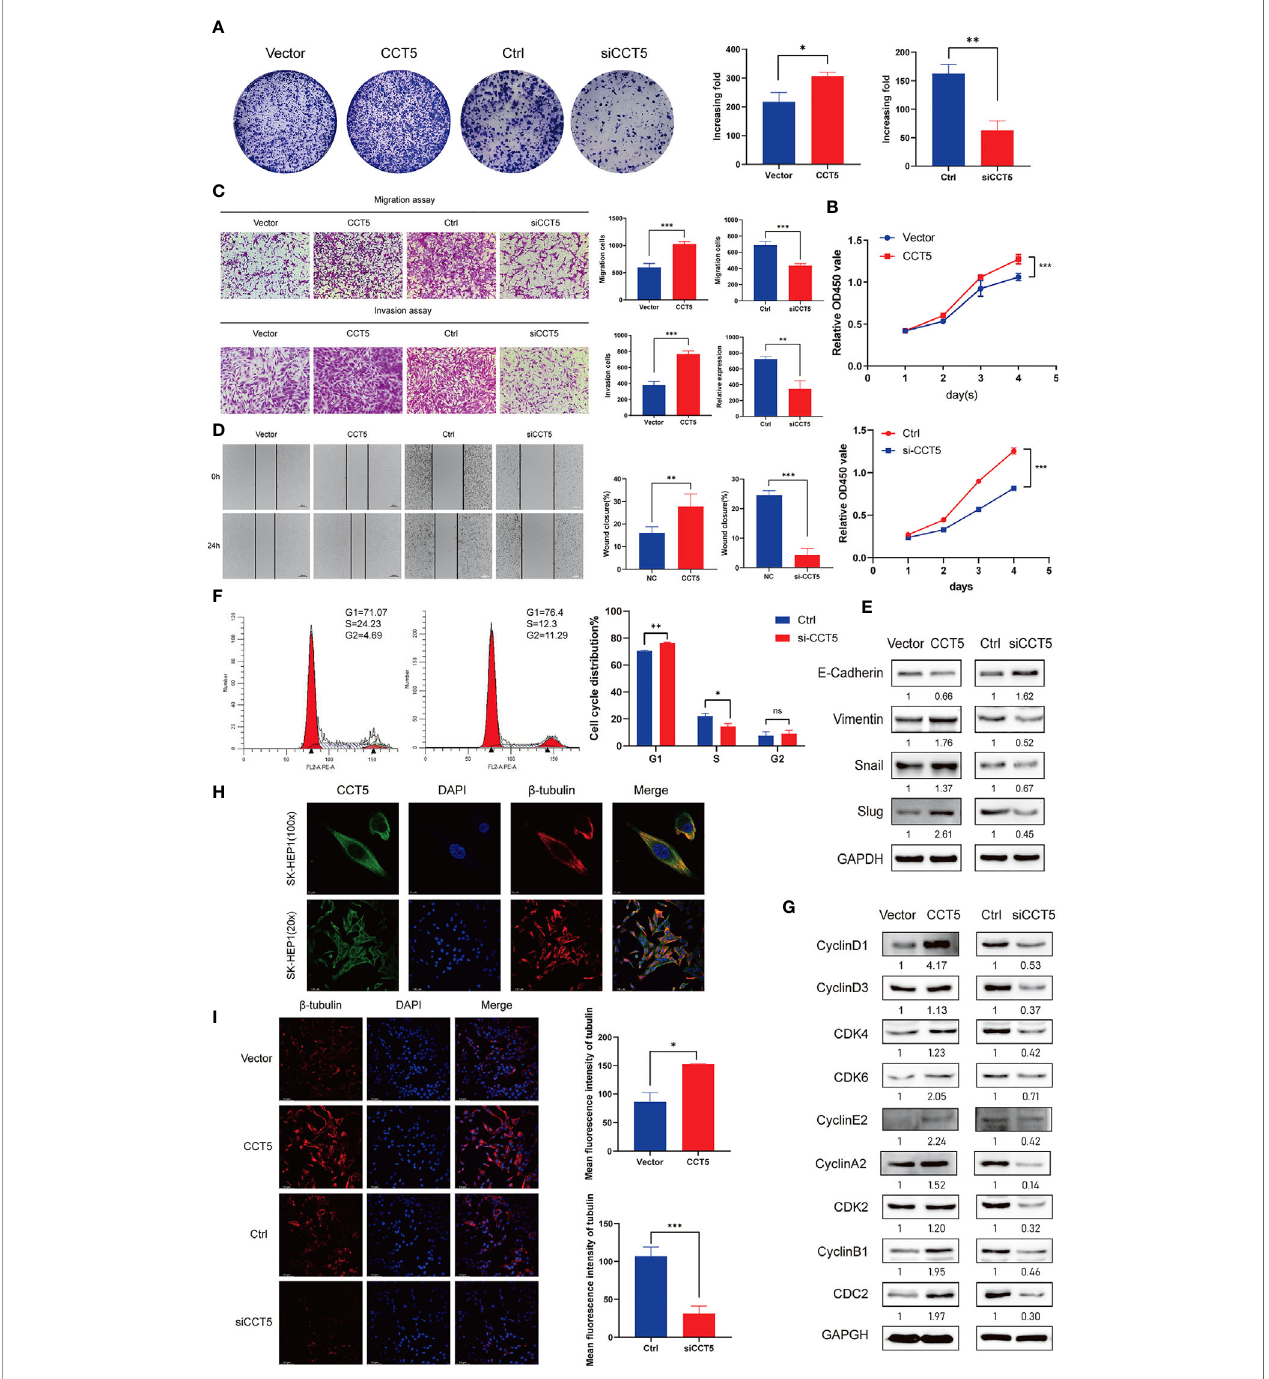
FIGURE 8 | Role of CCT5 in the proliferation, migration, invasion, and cell cycle regulation of HCC cells. (A) Colony formation assays showing the role of CCT5 on SK-HEP1 cell proliferation. (B) Cell viability of SK-HEP1cell line was determined by CCK-8 assays. (C) The effects of CCT5 on cell migration and invasion were determined by transwell assays in SK-HEP1 cell line. (D) The effects of CCT5 on cell migration were determined by wound healing assay in SK-HEP1 cell line. (E) The expression of EMT markers were examined by western blotting with CCT5 overexpression or downregulation. (F) The cell cycle distribution of SK-HEP1 cells were performed by fl ow cytometry analyses. (G) The relative expression levels of cyclin D1, cyclin D3, CKD4, CDK6, cyclin E2, cyclin A2, CDK2, cyclin B1, and CDC2 were examined by Western blotting in SK-HEP1 cells. (H) Fluorescence images show staining of CCT5 (green), DAPI (blue) and b -tubulin(red) in SK-HEP1 cells. Scale bar, 10 µm. (I) Representative images of b -tubulin(red) immuno fl uorescence staining in CCT5-overexpressing and CCT5-knockdown SK-HEP1 cells. Scale bar, 100 µm. Semi − quantitative analysis of b -tubulin fl uorescence intensity using ImageJ software. *p < 0.05, **p < 0.01, ***p < 0.001. ns, no signi fi